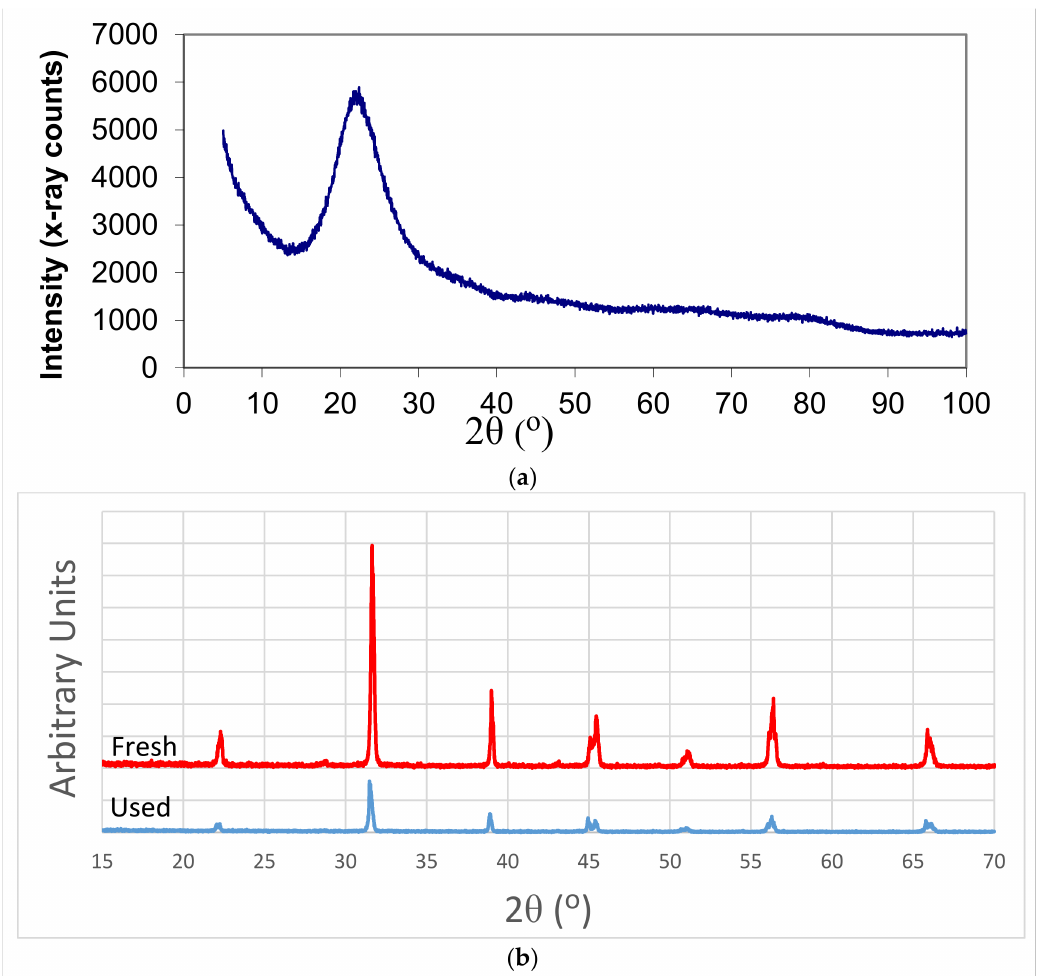
Figure 3. X-Ray Di ff raction (XRD) patterns of: ( a ) silica powder and ( b ) Barium titanate (BaTiO 3 ) samples before microwave irradiation (fresh) and after microwave irradiation (used) at 1800 W with plasma generation.